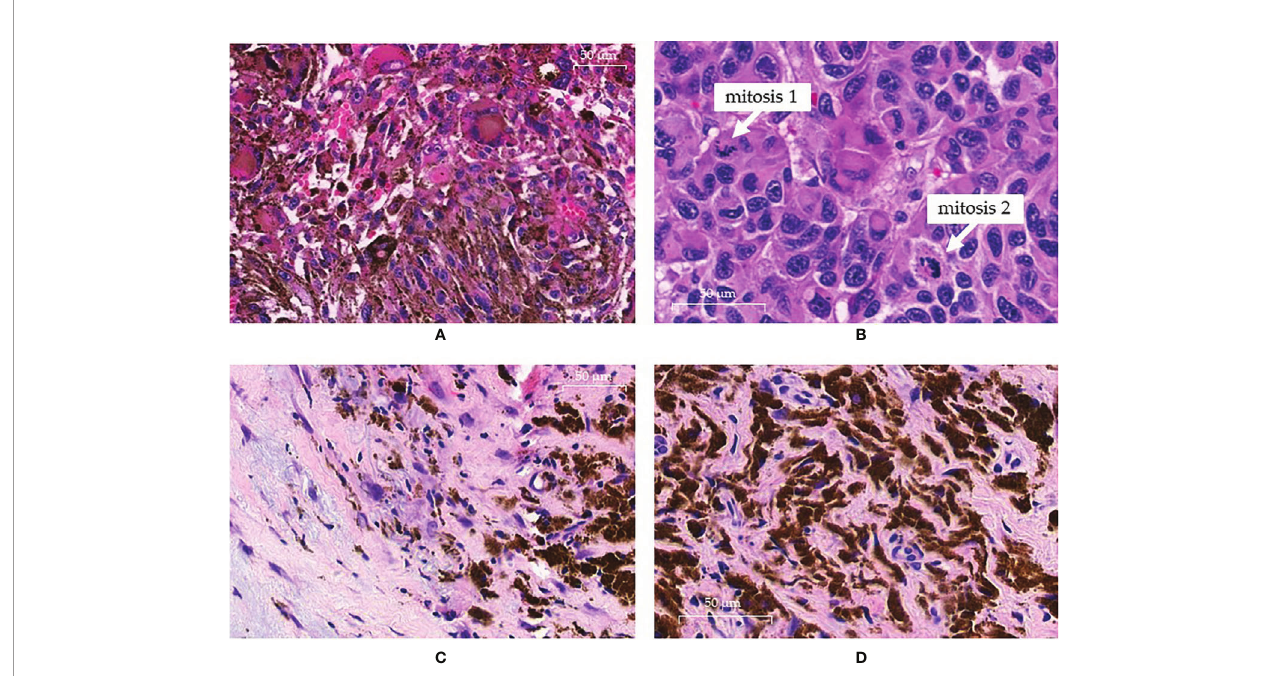
FIGURE 1 | Pathology fi ndings. (A, B) pre-treatment histology showing the presence of atypical neoplastic clones at high cellularity in the same sample: (A) fi eld with melanocytic clone of cells rich in cytoplasmatic melanic pigment; (B) other fi eld with an amelanotic clone displaying intense mitotic activity. (C, D) histologic sampling at complete response: (C) absence of neoplastic cells replaced by loose and dense fi brotic tissue with histiocytes; (D) histiocytes show cytoplasm intensely fi lled with melanic pigment.